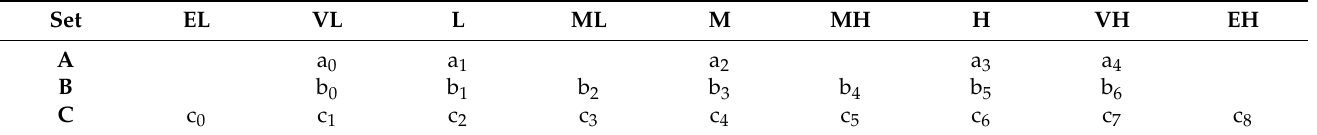
Table 2. Three linguistic term sets applied in this study (EL: Extremely Low; VL: Very Low; L: Low; ML: Moderately Low; M: Moderate; MH: Moderately High; H: High; VH: Very High; EH: Extremely High).